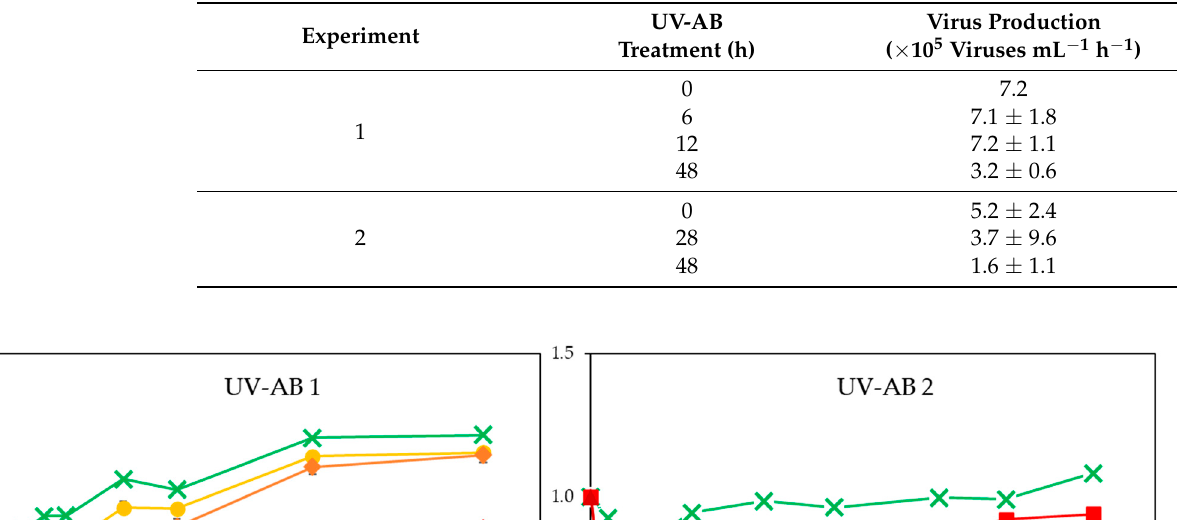
Table 1. Average virus production rates ( n = 2, average ± SD except for PAR-only controls (0 h UV) in experiment 1 where n = 1).